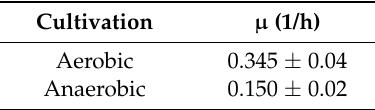
Table 1. Specific growth rate µ of batch phases determined by offline dry cell weight (DCW) measurements (given in Figure